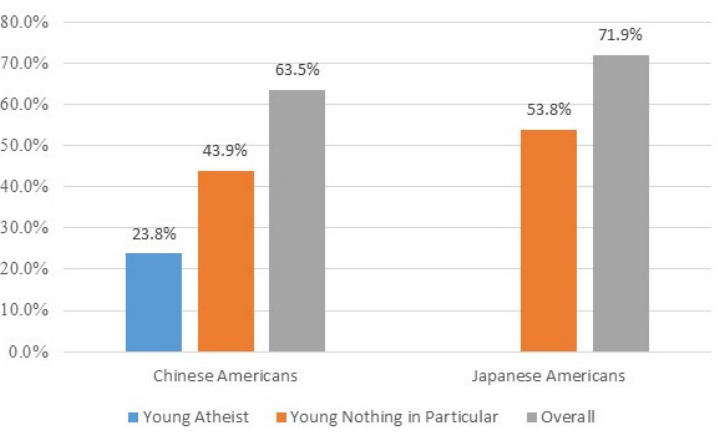
Figure 3. Importance of religion.